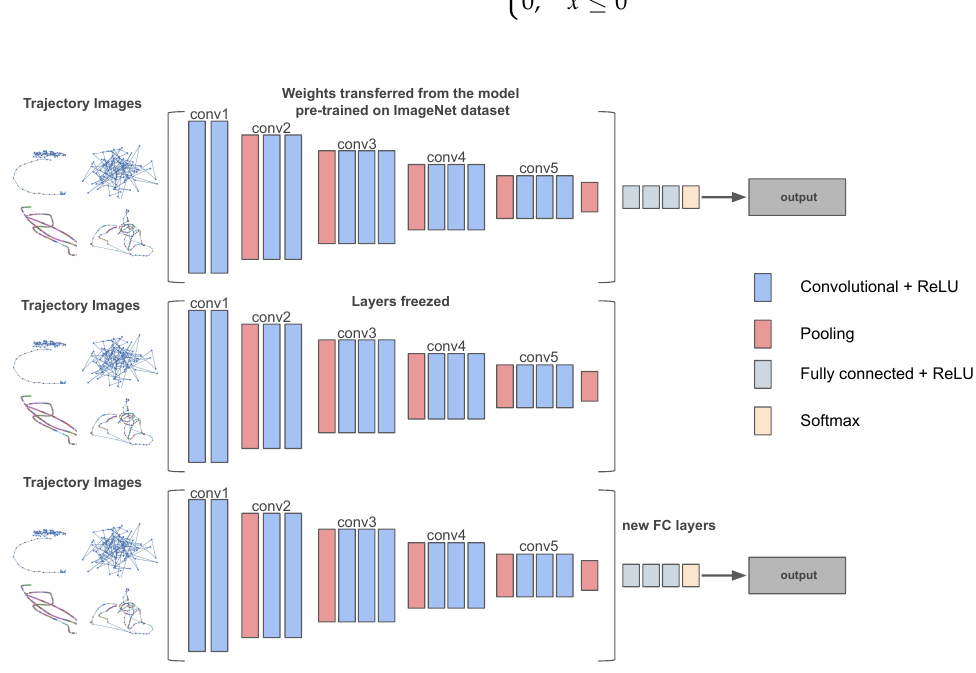
Figure 4. Fine-tuning on the VGG16 network